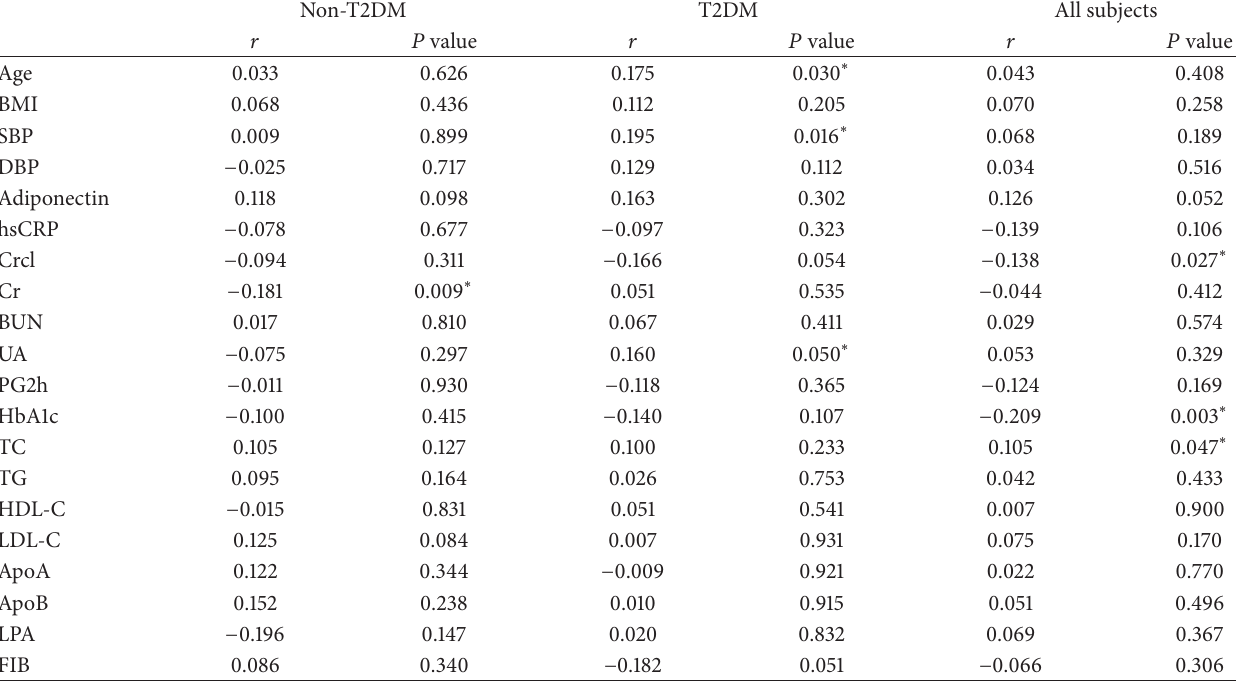
Table 3: Single univariate linear correlations of factors associated with serum vaspin